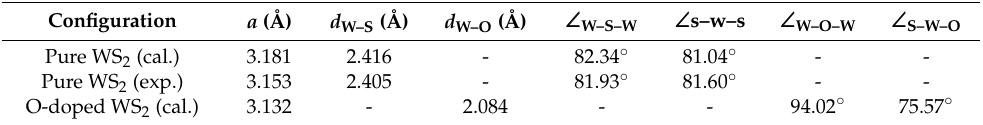
Table 1. Structural parameters of pure and O-doped 2 × 2 × 1 monolayer WS 2 .